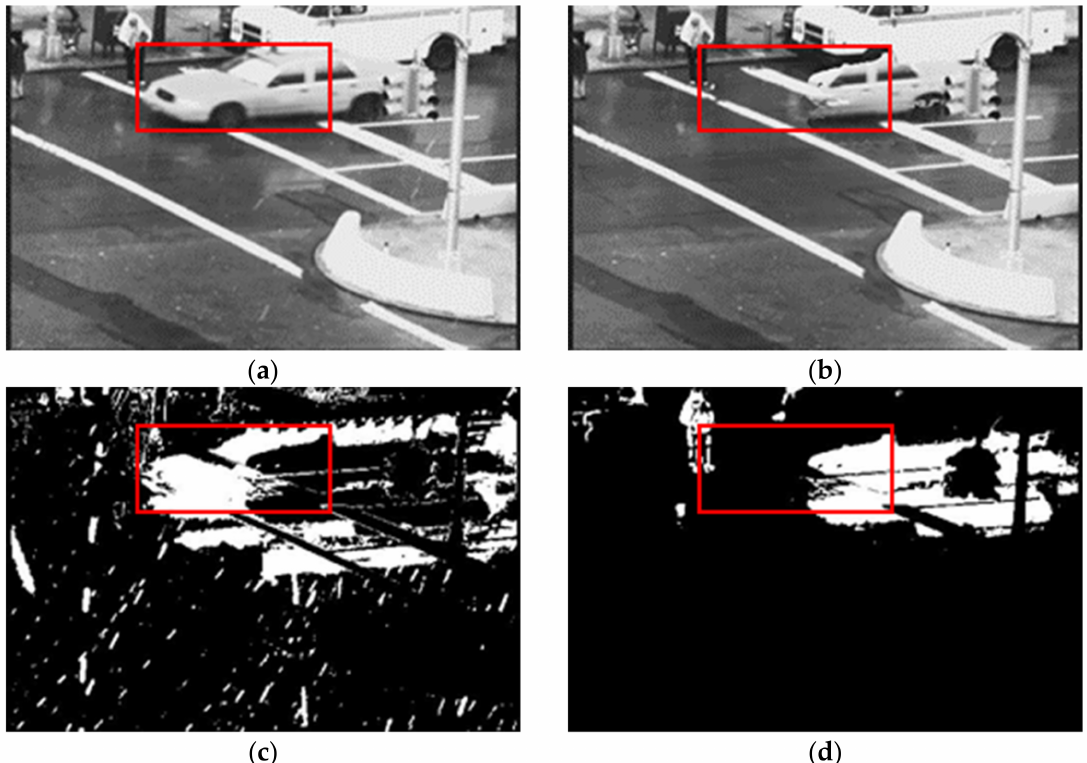
Figure 7. The output of the TA feature-based model of the video sequence “Traffic”. Red rectangle marked area shows indicates the limitation of TA model. ( a ) Input frame 79 ( b ) Generated rain-free image of frame 79 ( c ) Rain streaks of frame 79 and ( d ) TA Objects mask of frame